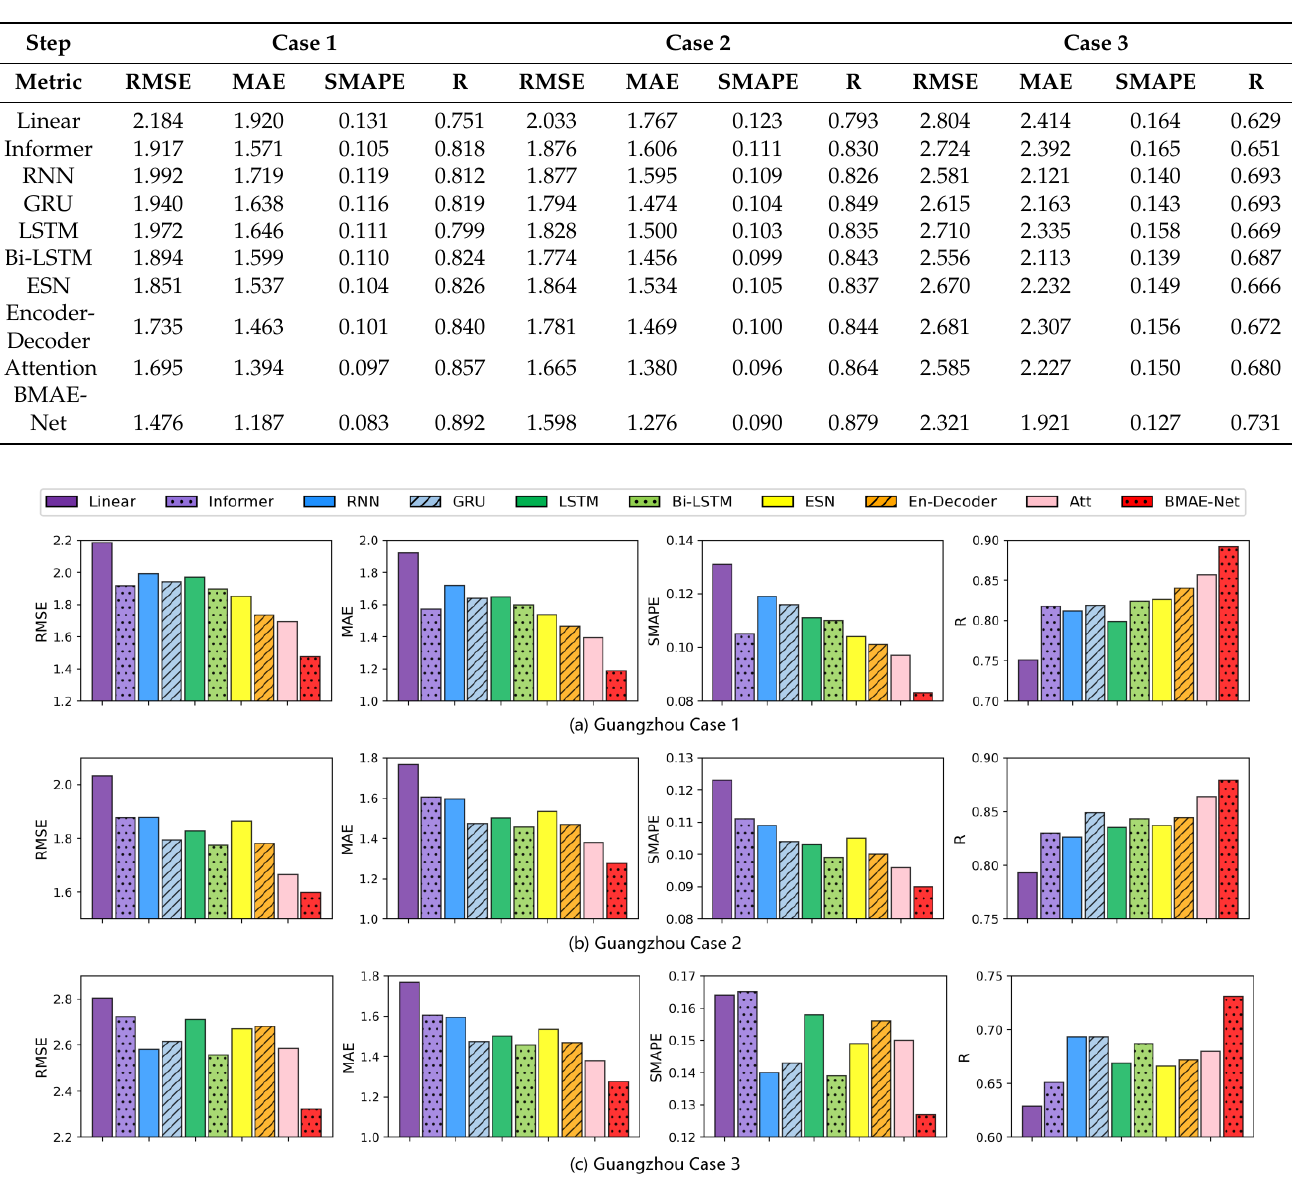
Figure 7. Bar graph of the temperature forecast evaluation index for the Guangzhou station.